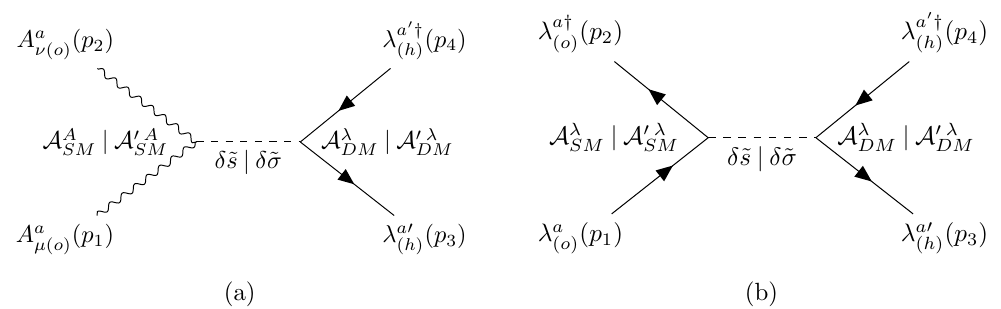
Figure 4. Possible gaugino dark matter production mechanisms. The massive δ ˜ s modulus can be produced during the gauge boson-gauge boson and gaugino-gaugino scattering in the thermal bath of particles in the observable sector during reheating. Based on the expected mass spectrum shown in table 1 of appendix B, and the possible interactions between the observable sector thermal bath and the hidden sector fields, we identified the hidden sector gauginos λ a 0 as one of the plausible ( h ) dark matter candidates within our theoretical context. For the observable sector gauginos, the index a runs over the adjoint representation of SU(3) C × SU(2) L × U(1) Y and any further extension of the standard model gauge group–such as U(1) in the B − L MSSM. For the hidden sector gauginos, B − L the index a 0 runs over the adjoint representation of the hidden sector group H which does not 1 contribute to gaugino